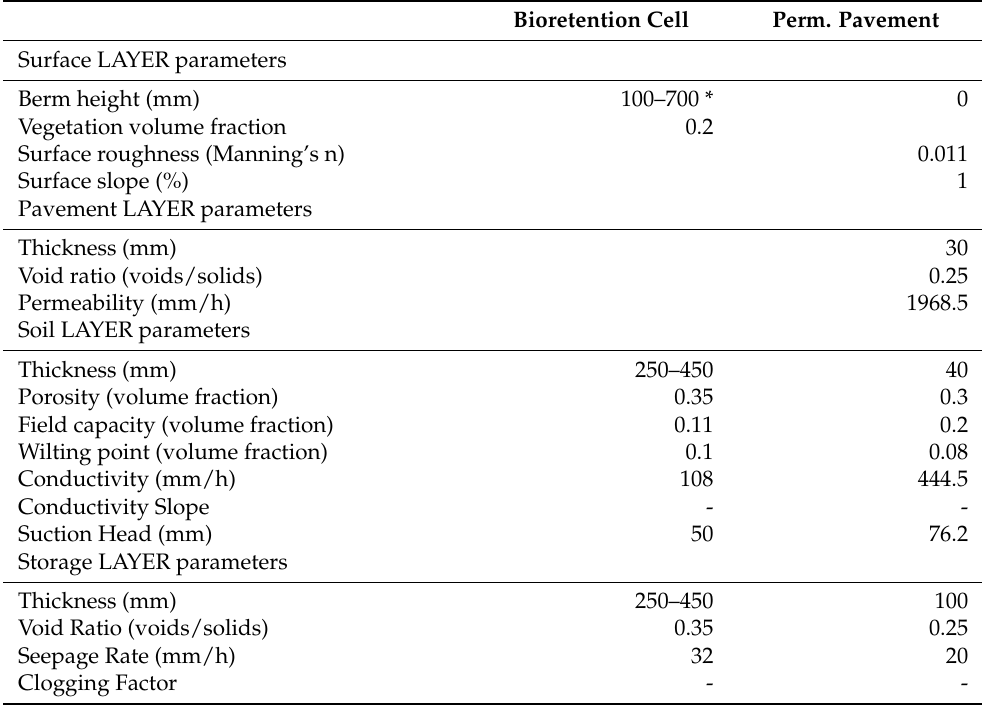
Table 3. Bioretention cell and permeable pavement LID control input parameters.